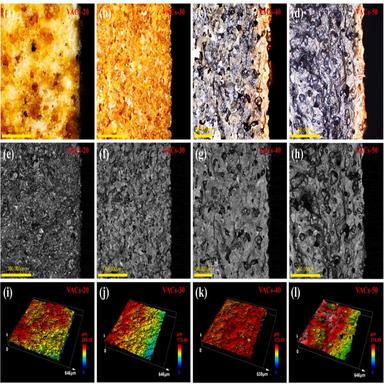
Fracture surfaces of VACs specimens with different WTPS additions: (a-d) CLSM color laser micrograph; (e-h) CLSM optical micrograph; (i-l) 3D topography.